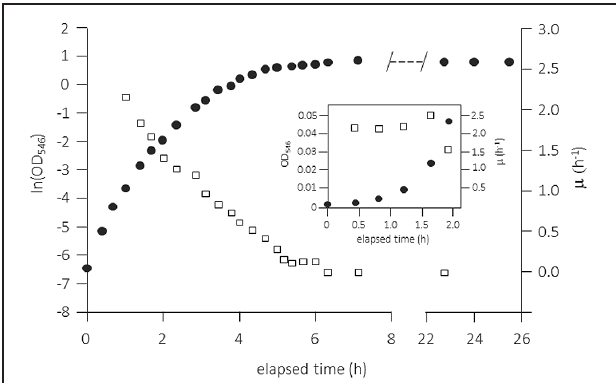
FIGURE 4 | Batch growth curve of Escherichia coli K-12 MG1655 in complex medium (Luria-Bertani broth, 25% original strength) in vigorously shaken flask. Growth was measured as OD 546 , the temperature was maintained at 37 ◦ C, and pO 2 was always > 70% air saturation. The specific growth rate µ (h − 1 ) was calculated as the slope of five adjacent points (empty squares). The inset shows the first 2 h of the experiment with µ determined from the slope of three adjacent points. Adapted from Berney et al. (2006) and amended with the inset. For more details see Berney et al.